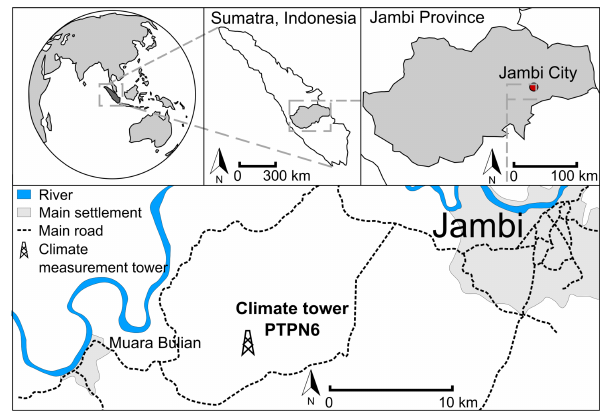
Figure 1. Map and location of the study site and climate measure- ment tower at PTPN6 oil palm plantation, approx. 15km southwest of the city of Jambi (Sumatra,